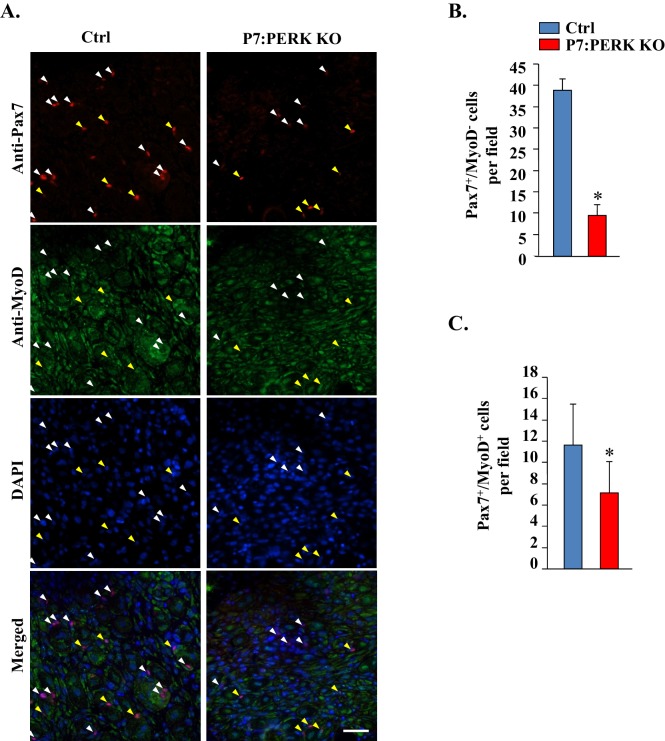
Targeted ablation of PERK reduces satellite cell count in injured muscle of mice.(A) Transverse sections generated from 5d-injured TA muscle of Ctrl and P7:PERK KO mice were immunostained for Pax7 and MyoD. Nuclei were counterstained with DAPI. Representative individual and merged images are presented here. White color arrows point to Pax7+/MyoD- cells whereas yellow arrows point to Pax7+/MyoD+ cells. Scale bar: 50 µm. Quantification of number of (B) Pax7+/MyoD- and (C) Pax7+/MyoD+ cells per field (∼0.15 mm2) in TA muscle section of Ctrl and P7:PERK KO mice. N = 4 in each group. *p<0.05, values significantly different from corresponding TA muscle of Ctrl mice by unpaired t-test.